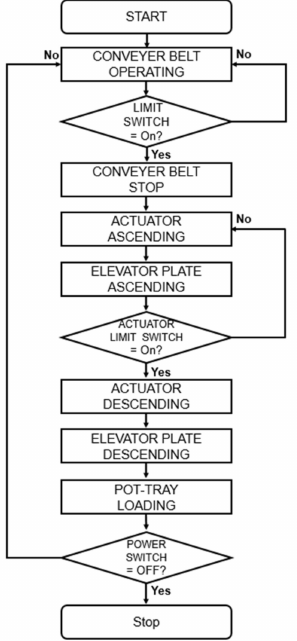
Figure 13. Flowchart of automatic accumulating equipment